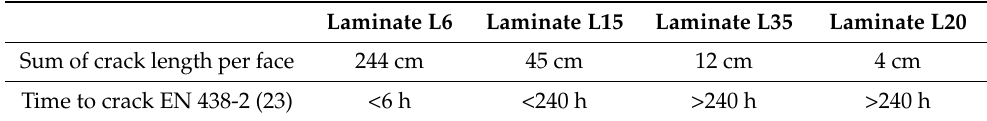
Table 2. Sum of the crack length of the four laminates glued to a carrier board and the corresponding time to crack in the modified EN 438-2(23) testing.